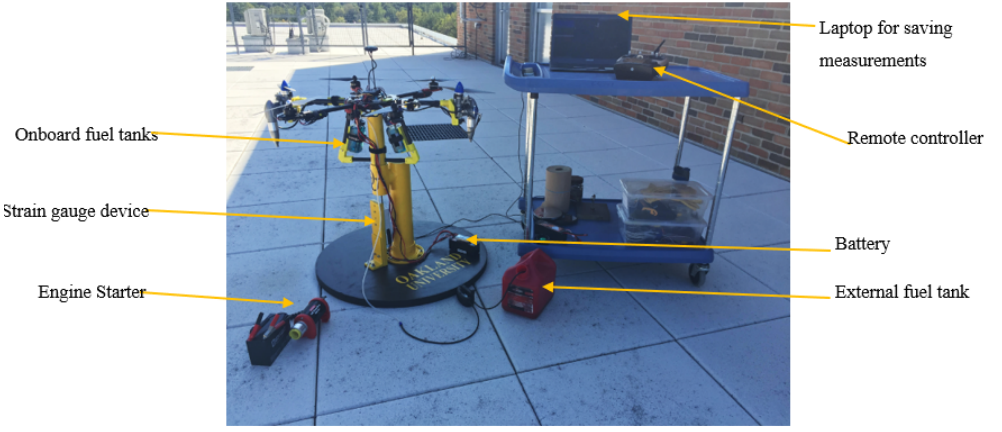
Figure 21. Equipment used in controlled experimental testing. The test stand enforced ideal hovering